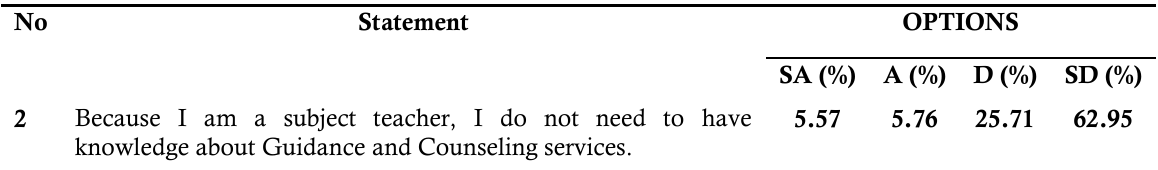
Table 4. Because I am a subject teacher, I do not need to have knowledge about Guidance and Counseling services